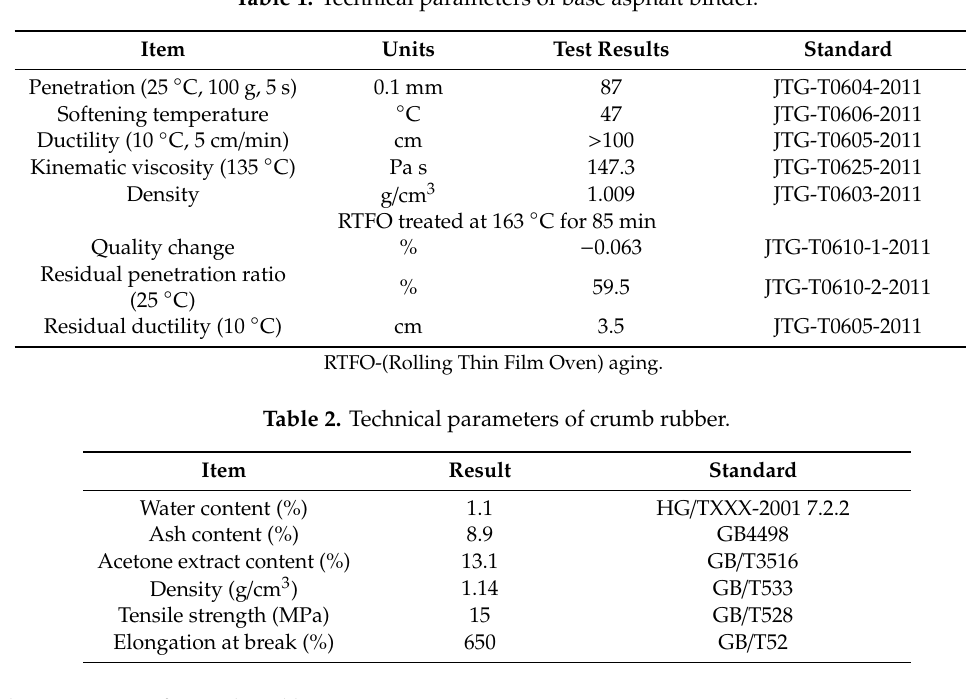
Table 1. Technical parameters of base asphalt binder.